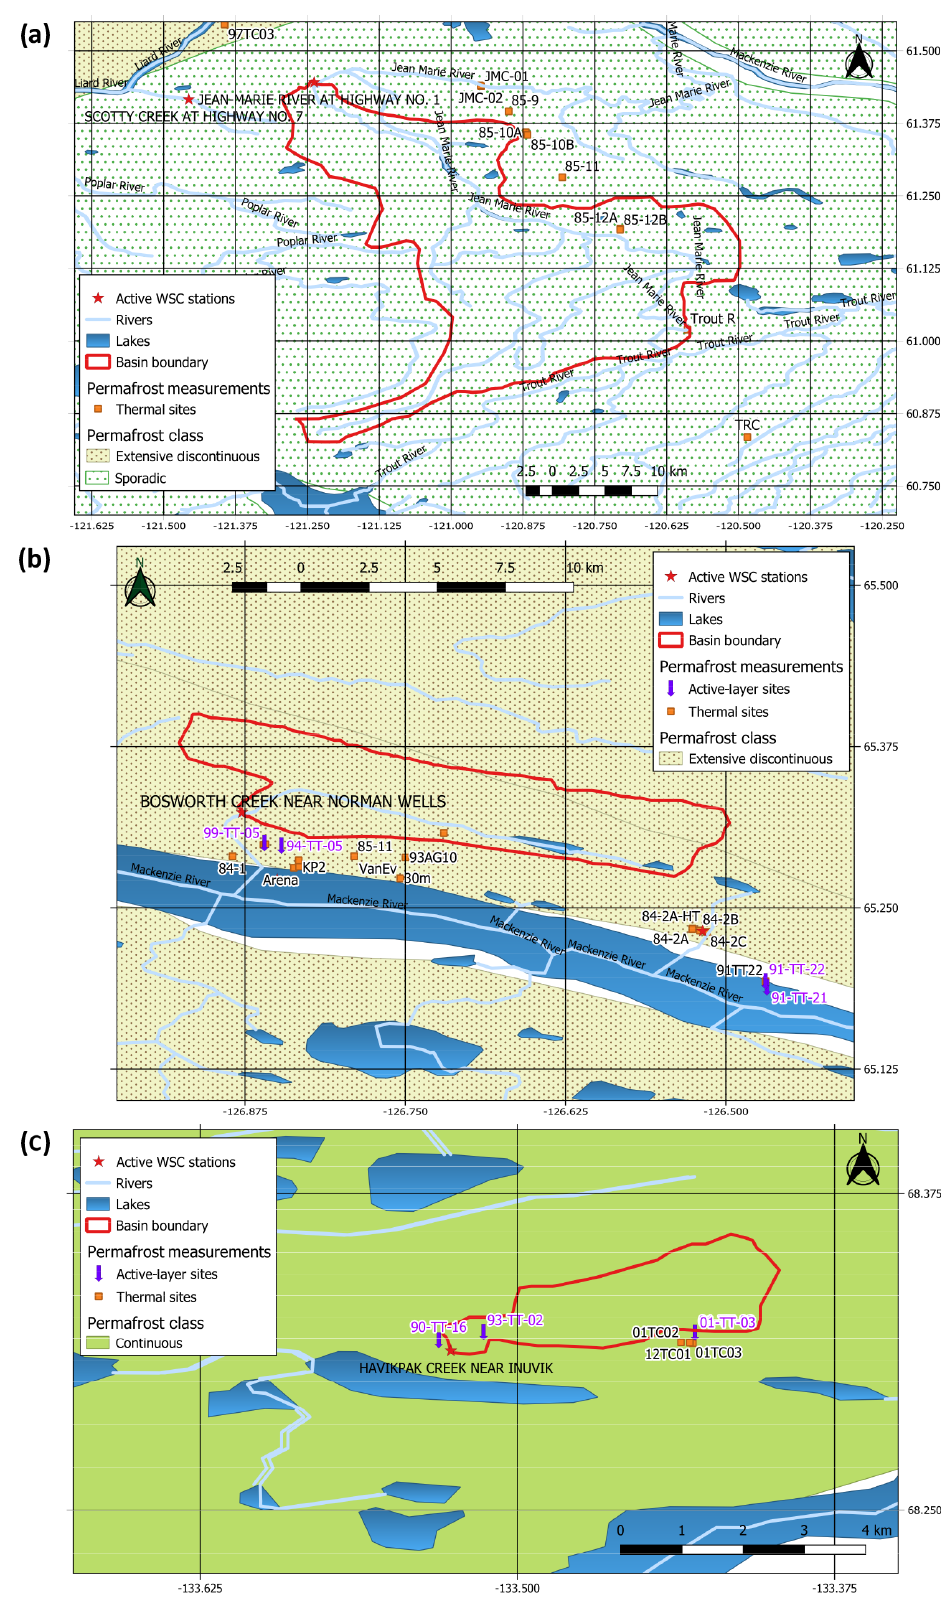
Figure 3. Location of and permafrost measurement sites in the (a) Jean Marie River sub-basin, (b) Bosworth Creek sub-basin, and (c) Havikpak Creek